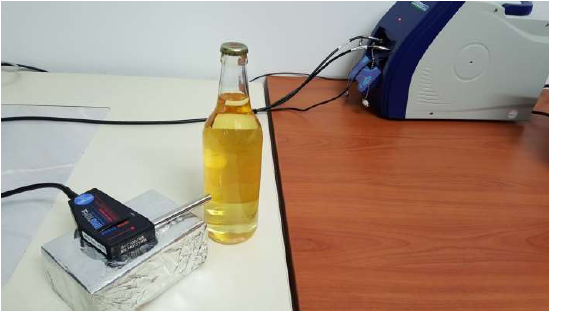
Figure 3. Portable Raman setup for the in-line analysis of drinks and spirits. A bottle of beer is placed as the sample.